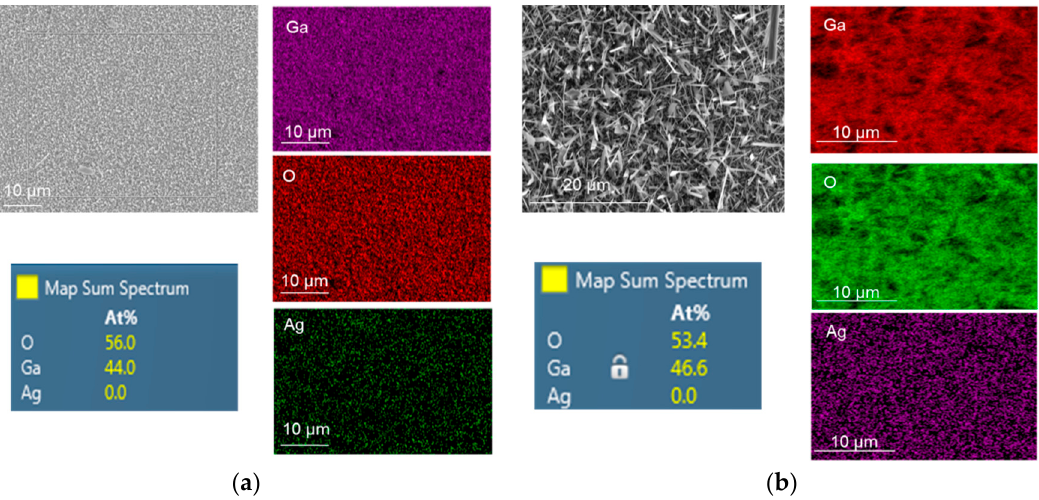
Figure 6. Energy dispersive spectroscopy (EDS) mapping of Ga 2 O 3 grown at 1000 °C on quartz surface: ( a ) Nanocrystalline film of Ga 2 O 3 . ( b ) Ga 2 O 3 nanowires catalyzed by 5 nm Ag. Longer and denser NWs were achieved when Ag was used as a catalyst.